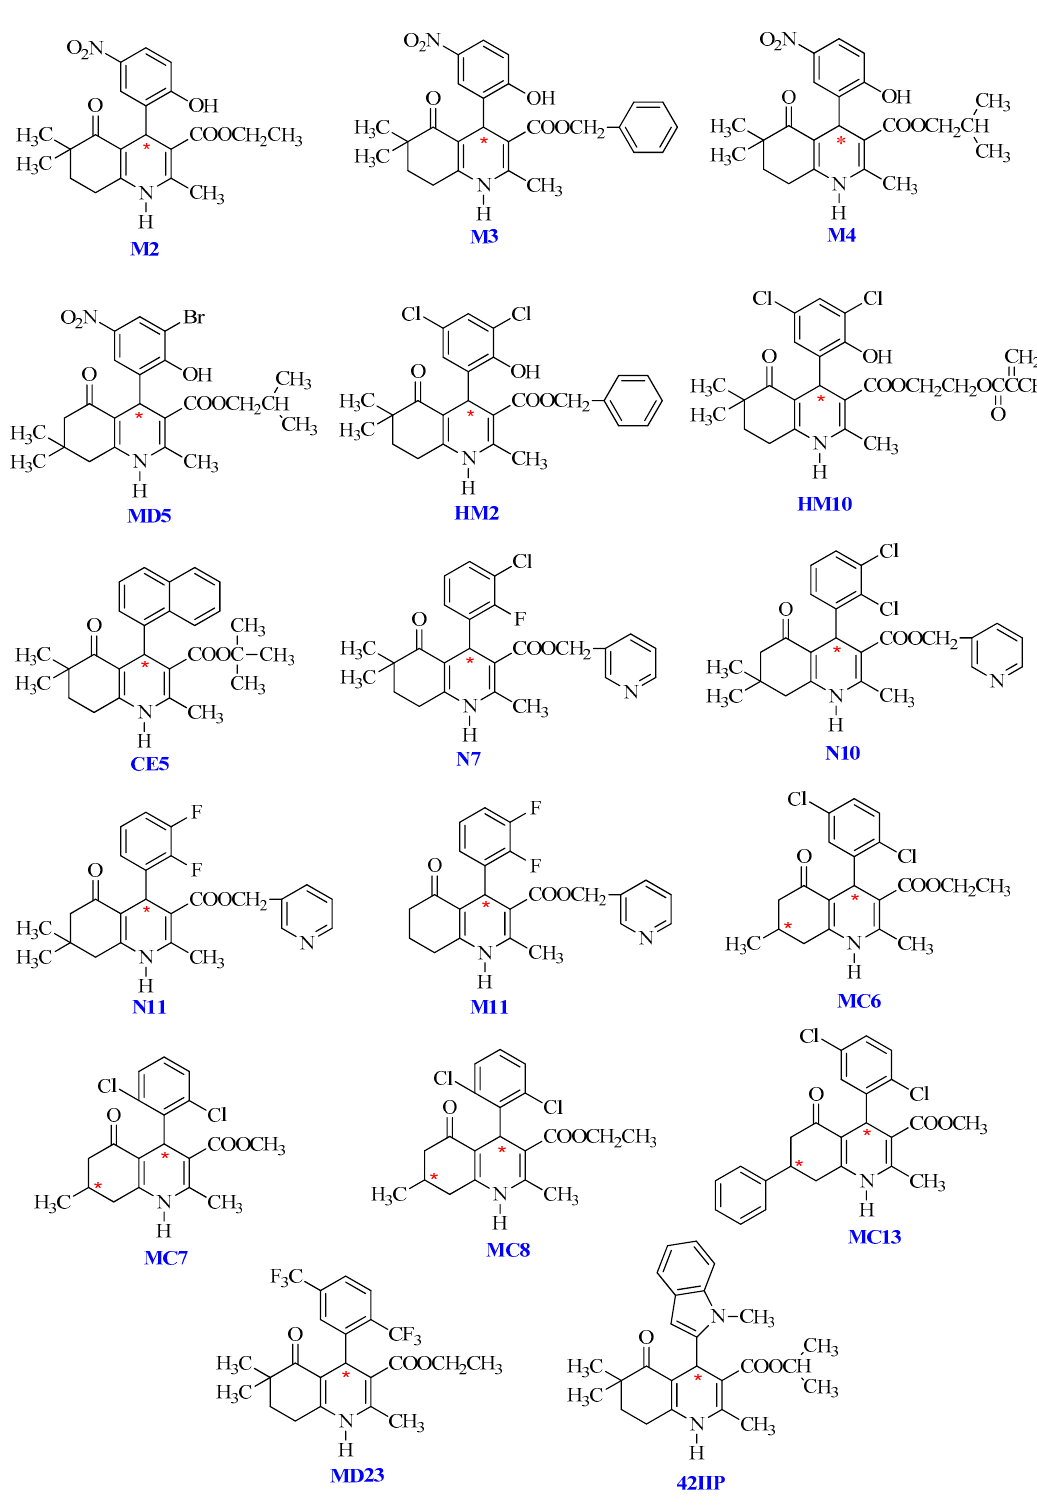
Figure 1. Chemical structures of studied compounds.